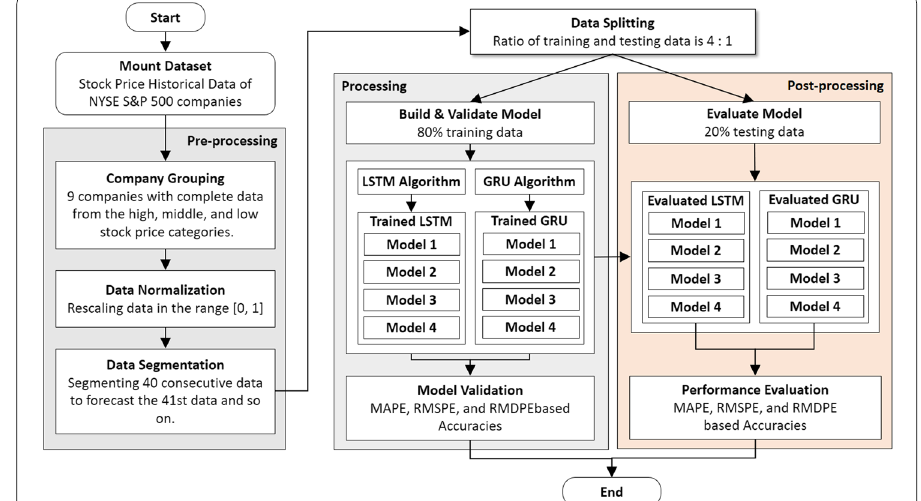
Fig. 1 Proposed LSTM and GRU forecasting method